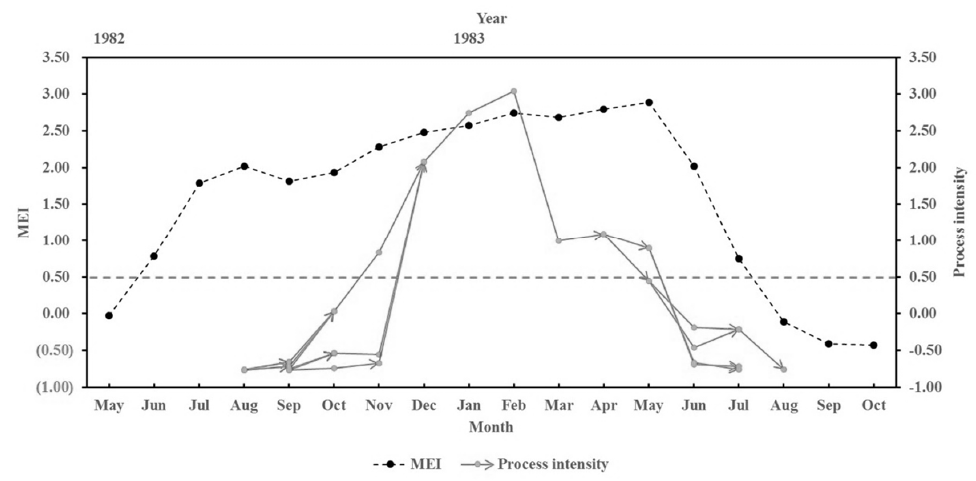
Figure 14. An evolution of the process objects of SSTA and its relationship with ENSO.